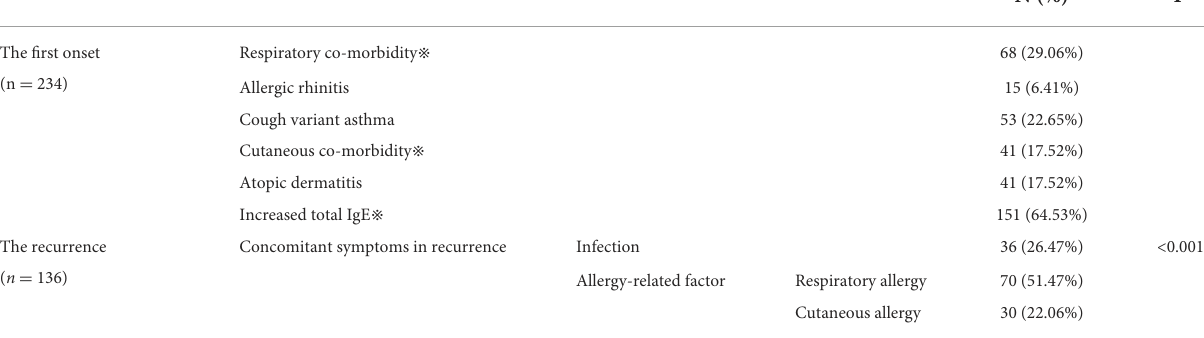
TABLE 1 The co-morbidity in children with PNS and atopic diseases and the triggers of recurrence and season of recurrence in children with